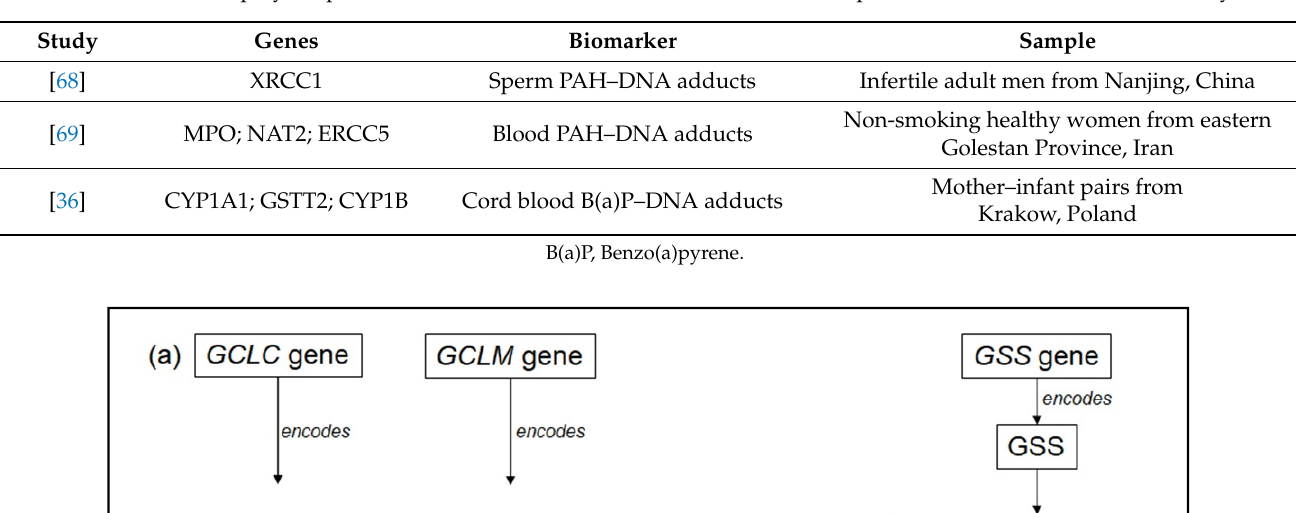
Table 2. List of epidemiological studies investigating the influence of genetic polymorphisms on PAHs toxicokinetics. Genes in which the above polymorphisms were identified, biomarkers affected, and samples studied are shown for each study.